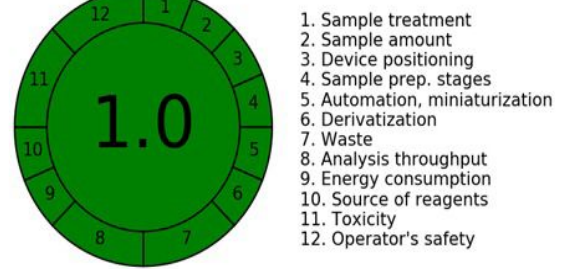
Figure 3. AGREE pictogram after weight modification.